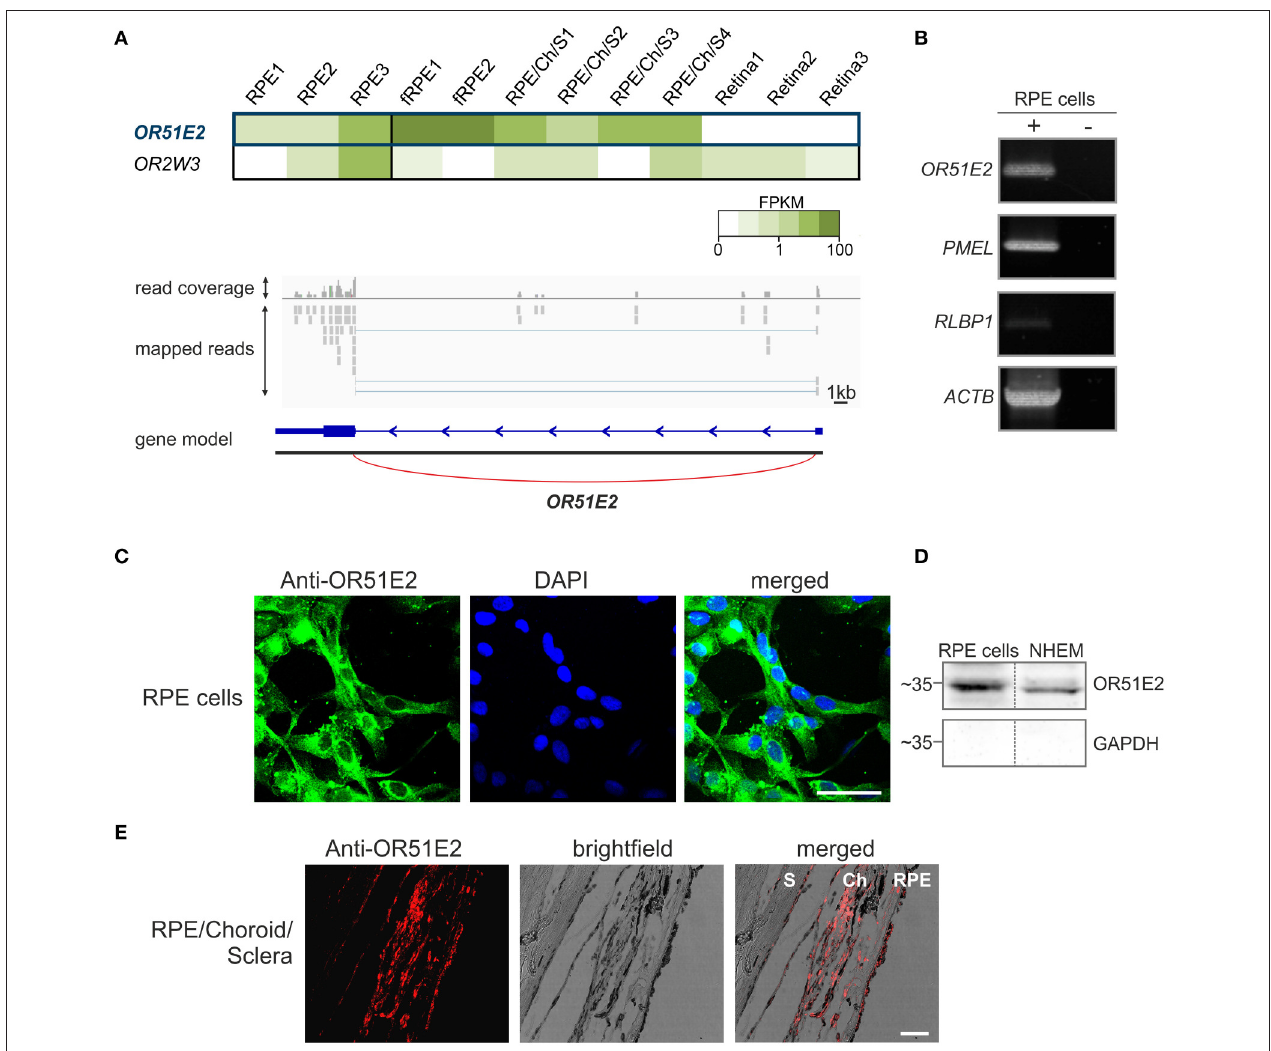
FIGURE 1 | OR51E2 is expressed in human retinal pigment epithelial cells. (A) The heat map shows the FPKM values for the most abundant ORs (mean FPKM > 0.3) in three whole RPE samples compared to fetal RPE (fRPE), retina supporting tissue (RPE/Choroid/Sclera) and the three neural retina samples (upper panel). The darker colors indicate higher FPKM values and white indicates the absence of any detectable transcripts. Representation of the read coverage of the OR51E2 transcripts detected in primary RPE cells and visualized by the Integrative Genomic Viewer (lower panel). The gray segments indicate the reads that were mapped onto the reference genome. The gene is indicated by the blue bars (exon), and thin line (intron) with an arrowhead that shows the reading direction. Read coverage is shown above (detected and mapped counts/bases at each respective position). (B) Detection of OR51E2 transcripts in primary RPE cells by RT-PCR. Gel electrophoresis of amplicons from primary RPE cell cDNA ( + ) and no reverse transcriptase cDNA controls (–) to exclude genomic DNA contamination. Premelanosome protein ( PMEL ) and Retinaldehyde-binding protein 1 ( RLBP1 ) expression identifies RPE cells. The amplification of β -actin ( ACTB) served as a control for cDNA quality. (C) Immunofluorescence confocal micrographs of RPE cells labeled with an OR51E2 specific antibody (green) and DAPI to visualize the nuclei (blue). An intracellular staining of OR51E2 can be observed. The bar indicates 50 µ m. (D) Plasma membrane localization of OR51E2 in RPE cells verified by surface biotinylation and detection by Western blotting. A representative Western blot of biotinylated membrane of the RPE cells and melanocytes (NHEM), as a positive control, is shown. The cytosolic protein GAPDH served as a control for the enrichment of cell surface proteins and lack of cytosolic proteins. (E) Immunofluorescence confocal micrographs of a histological section of RPE, choroid (Ch) and sclera (S) co-labeled with an OR51E2-specific antibody (red). The bar indicates 50 µ m.